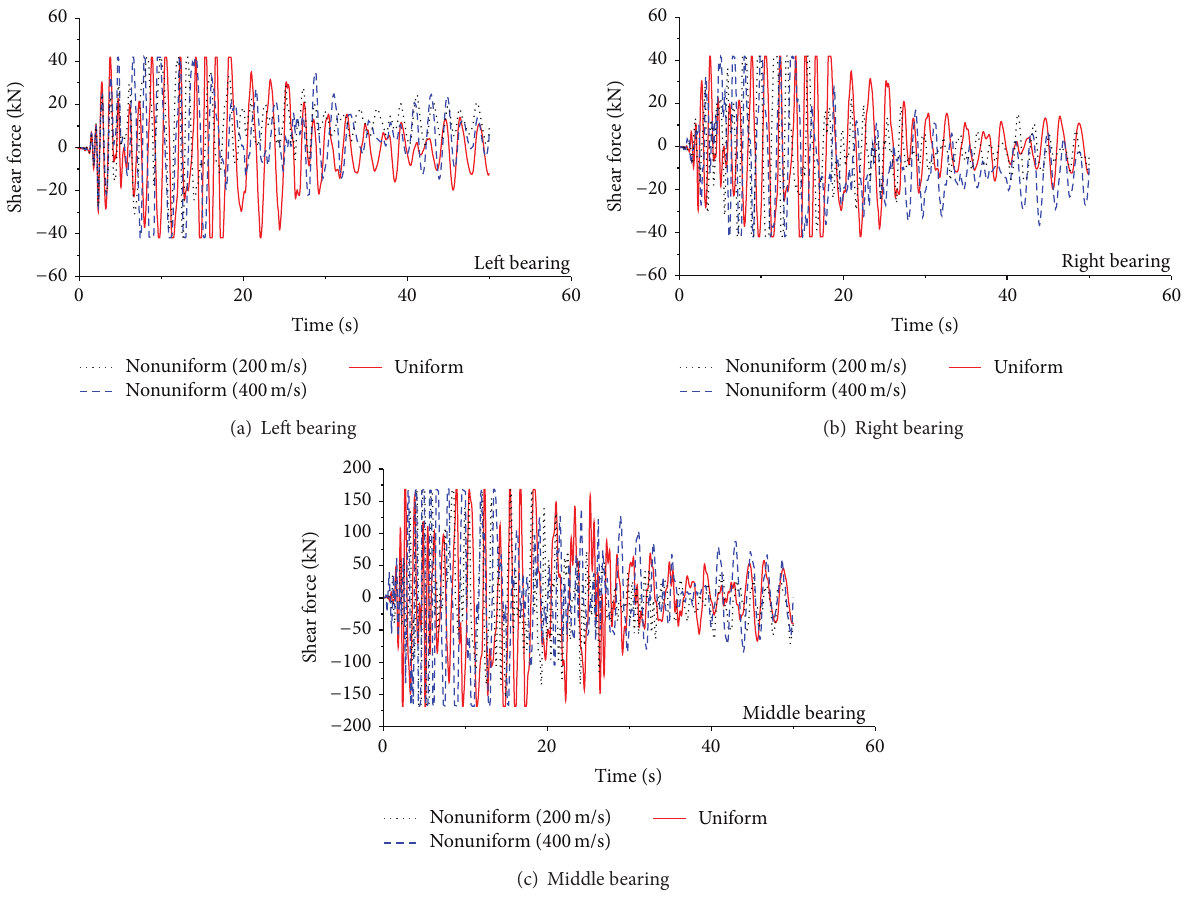
Figure 10: Time history of shear force of bearings. Table 1: Bearing